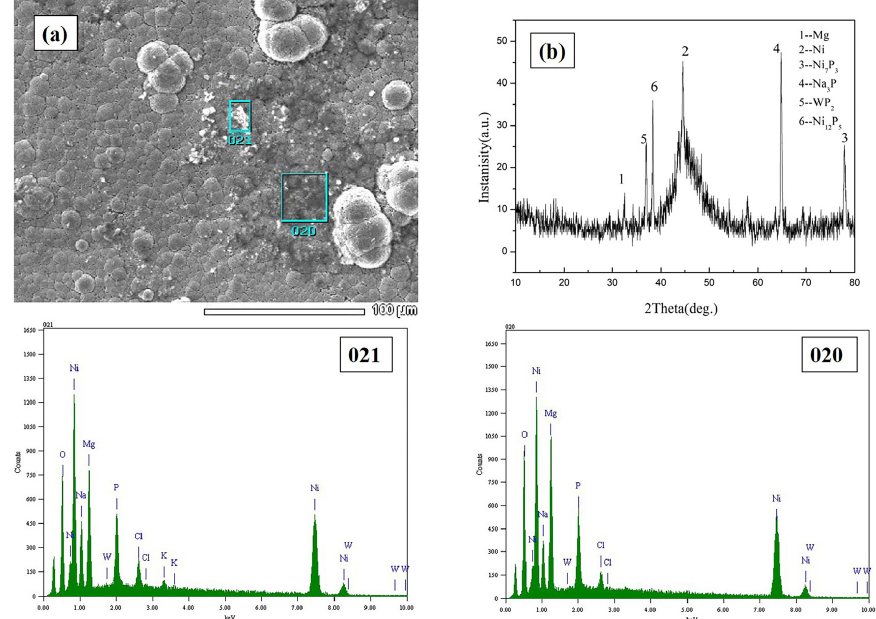
Figure 13. (a) Energy spectrum analysis of Ni-W-P coatings immersed in 3.5 wt.% NaCl solution for 72 h. (b) XRD diffraction of Ni-W-P coatings immersed in 3.5 wt.% NaCl solution for 72 h.